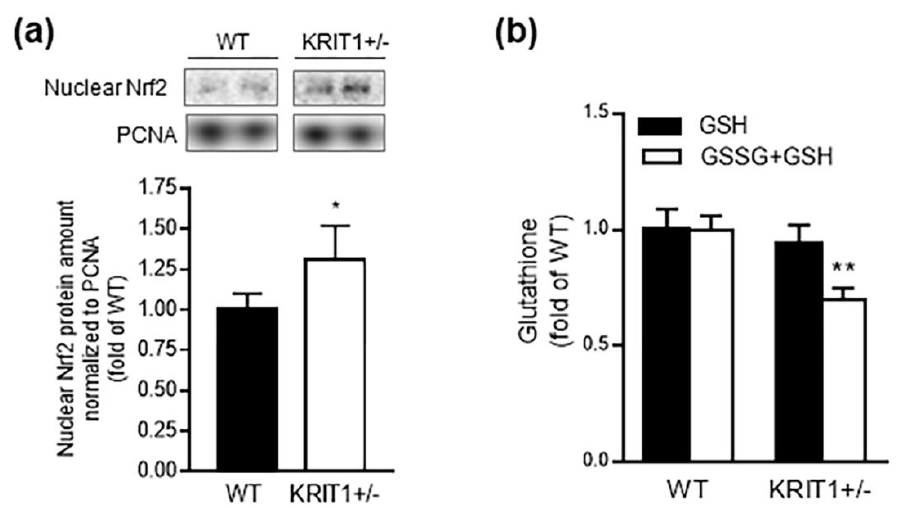
Figure 5. Heterozygous loss of KRIT1 in mice altered hepatic antioxidant systems. ( a ) Representative Western blot analysis of liver homogenates showing an increased nuclear accumulation of the antioxidant transcription factor Nrf2 (nuclear factor erythroid 2-related factor 2) in the liver of KRIT1 +/ − vs. WT mice. The histogram represents the densitometric quantification of Nrf2 bands of 7 mice per group normalized to the corresponding loading control [proliferating cell nuclear antigen (PCNA)]. ( b ) Analysis of reduced glutathione (GSH) and total glutathione (GSSG + GSH) levels in liver homogenates from WT and KRIT1 − / − mice. Data are means ± SEM of 7 mice per group and are presented as fold changes relative to the WT control. * p < 0.05; ** p < 0.005 vs. WT.